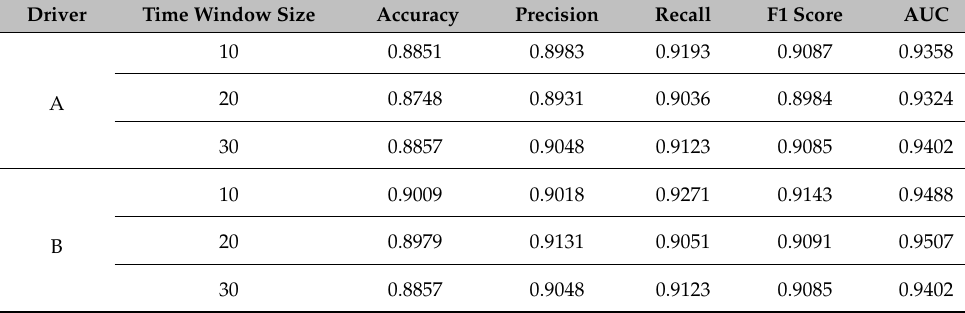
Table 9. Evaluation results on the new drivers’